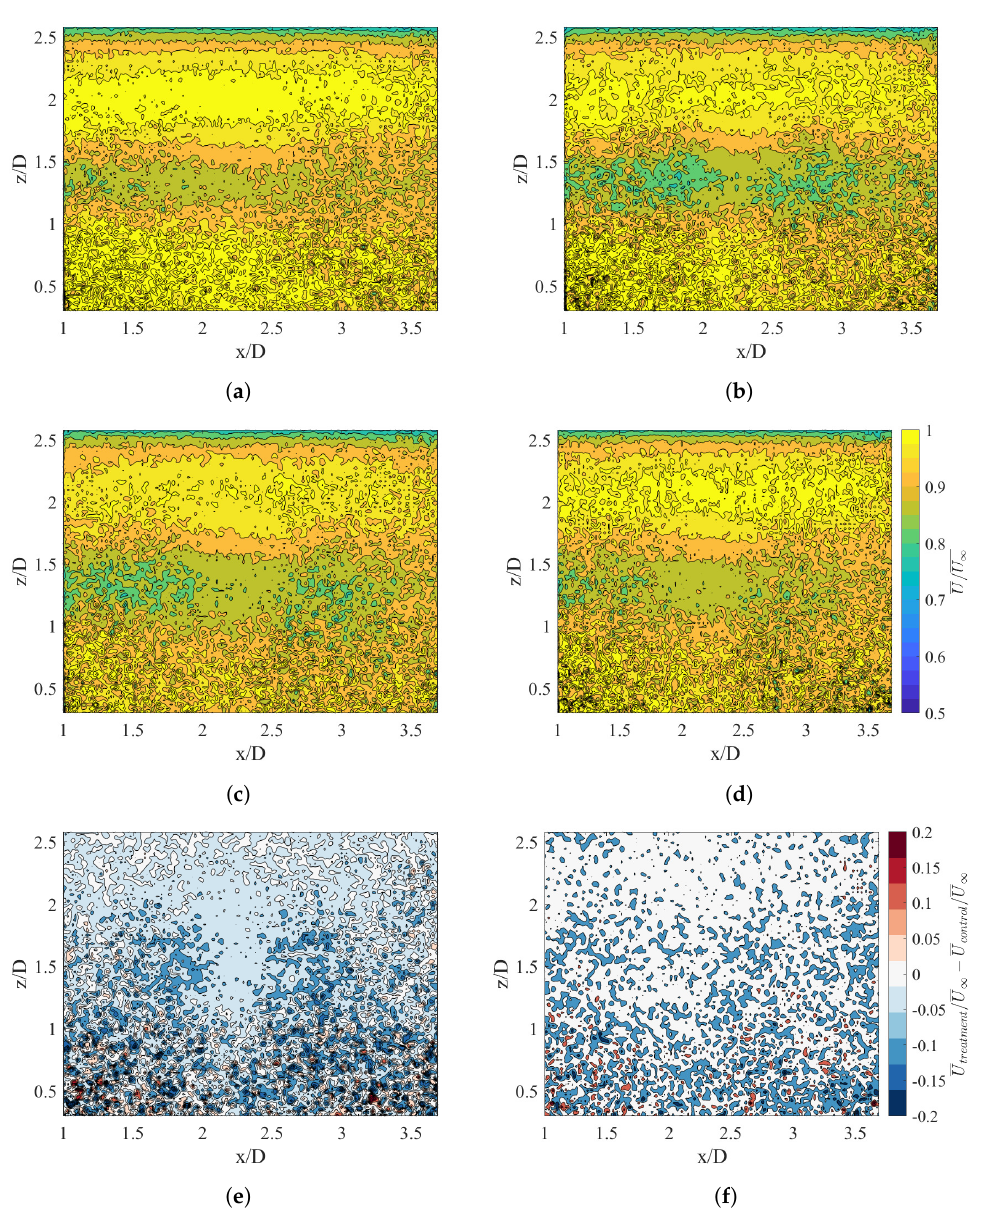
Figure 11. ( a – d ) Contours of the PIV recorded time-averaged streamwise velocity along the rotor tip plane of the array normalized by the time-averaged freestream velocity. The intersection of the upstream rotor plane and the flume bed is at coordinate (0,0): ( a ) control case between rows one and two; ( b ) control case between rows two and three; ( c ) treatment case between rows one and two; ( d ) treatment case between rows two and three; and ( e , f ) the differences between treatment and control between rows one and two and two and three,